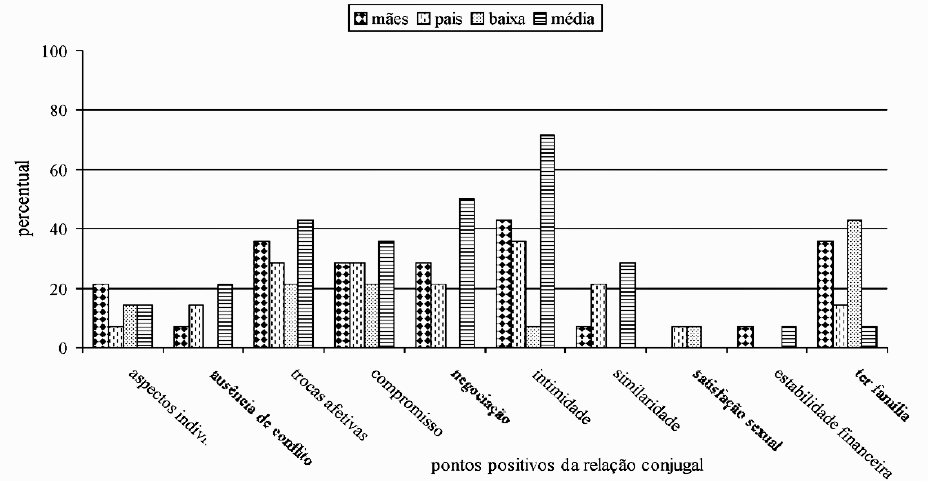
Figura 4. Pontos positivos da rela(cid:231)ªo conjugal, segundo o relato de pais e mªes de classes mØdia e baixa. Psicologia: Reflexªo e Cr(cid:237)tica, 2005, 18(2),